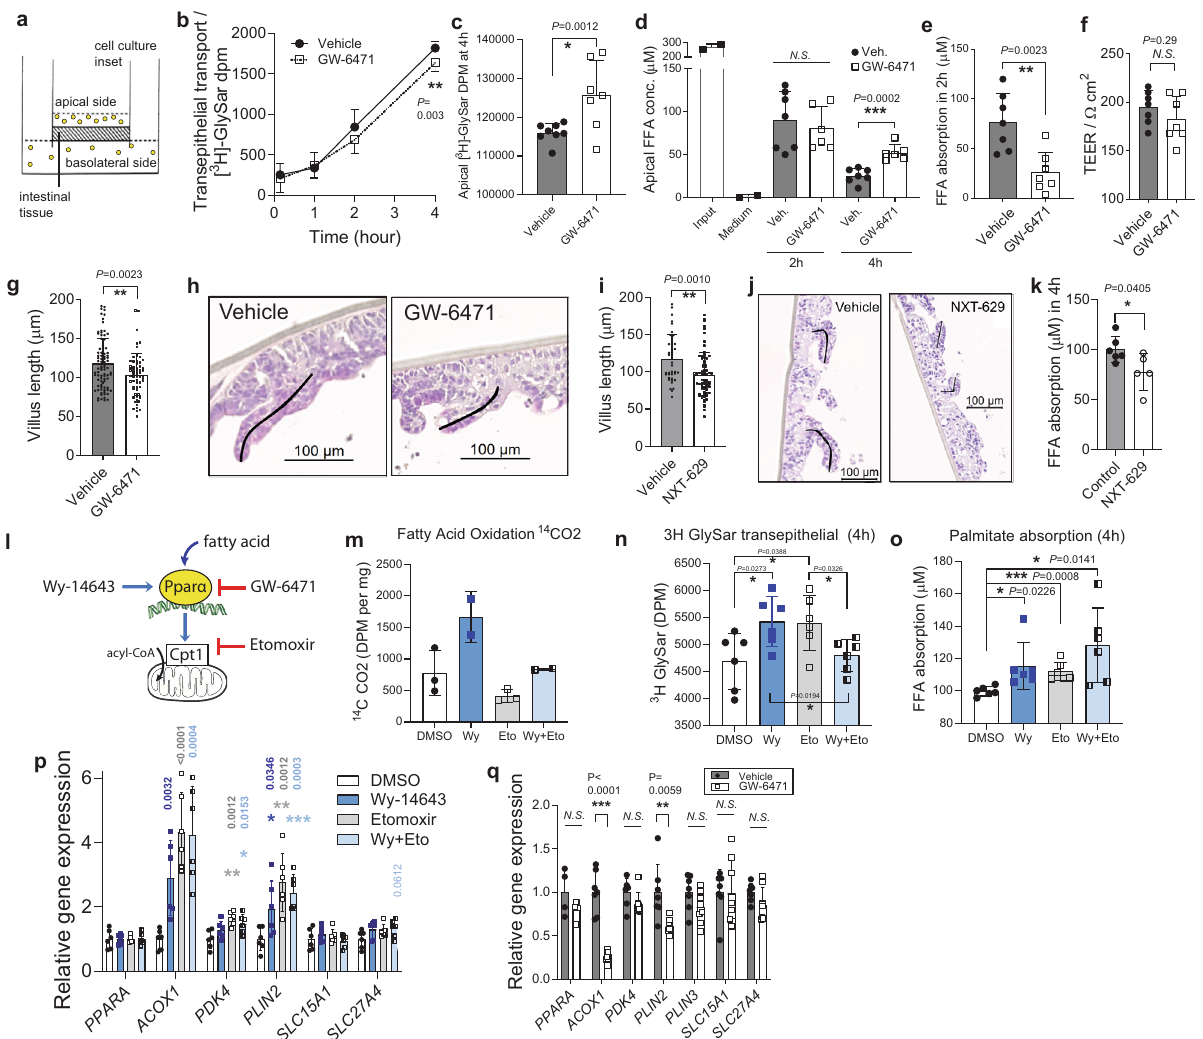
Fig. 5 PPAR α antagonism reduces fatty acid uptake and villi length in human intestinal biopsies. a Graphical representation of the human epithelial biopsy culture. b , c Basolateral ( b ) and apical radioactivity ( c ) of dipeptide [ 3 H]GlySar, n = 7 per group of epithelial biopsy insets cultured seven days with PPAR α antagonist 5 μ M GW-6471 or DMSO. d , e Apical concentration of free fatty acids ( d ) and calculated palmitate absorption between 2 and 4 h, n = 7 (vehicle), 6 (GW-6471) biopsy insets ( e ). f Trans-epithelial electrical resistance at the end of the experiment, n = 7 (vehicle), six (GW-6471) biopsy insets. g , h Full villi lengths n = 88 (vehicle), 63 (GW-6471), pooled from n = 5 (vehicle), four (GW-6471) biopsy insets after nine days of treatment ( g ) and representative H&E staining with villi tracing ( h ). i , j Full villi lengths after nine days of incubation with PPAR α antagonist 5 μ M NXT-629 ( n = 70 villi), or vehicle ( n = 38 villi), pooled from four cell culture insets per group ( i ) and representative H&E staining of villi ( j ). k Palmitate absorption in 4 h, from n = 6 (vehicle) and four (NXT-629) insets per group, calculated from apical FFA concentration measurements. l Graphical representation of the mechanism of pharmacological PPAR α agonism (Wy-14643) and antagonism (GW-6471), and of the fatty acid oxidation inhibitor etomoxir. m Fatty acid oxidation in human epithelial samples measured by scintillation counting of [ 14 C]CO 2 that is released by in vitro β -oxidation of [ 14 C]-palmitate, n = 2 (DMSO, etomoxir), three (Wy-14643, Wy-14643 + etomoxir). n – p Basolateral radioactivity of dipeptide [ 3 H]GlySar after 4 h of transport ( n ), palmitate absorption in 4 h, calculated from apical FFA measurements ( o ) and relative qPCR gene expression in epithelial biopsies, normalized to Tbp ( p ) after 10-day inhibition with DMSO, 4 μ M Wy-14643, 50 μ M etomoxir, and Wy-14643 + etomoxir, n = 6 biopsy insets per group. q Relative qPCR gene expression after GW-6471 treatment, n = 7 (vehicle), eight (GW-6471) insets per group. b – h and q are pools from two independent experiments. All data represent mean ± S.D, * P ≤ 0.05, ** P < 0.01, *** P < 0.001 of t -test con fi dence level 95%. Source data are provided as a Source Data fi